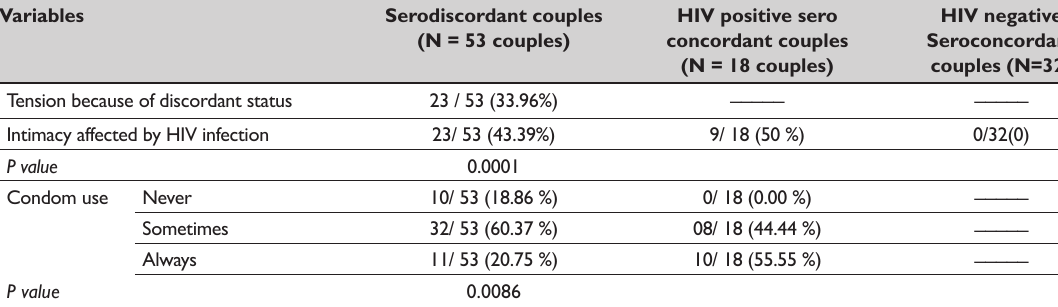
Table 2: Effects of HIV status on intimacy and sexual relations